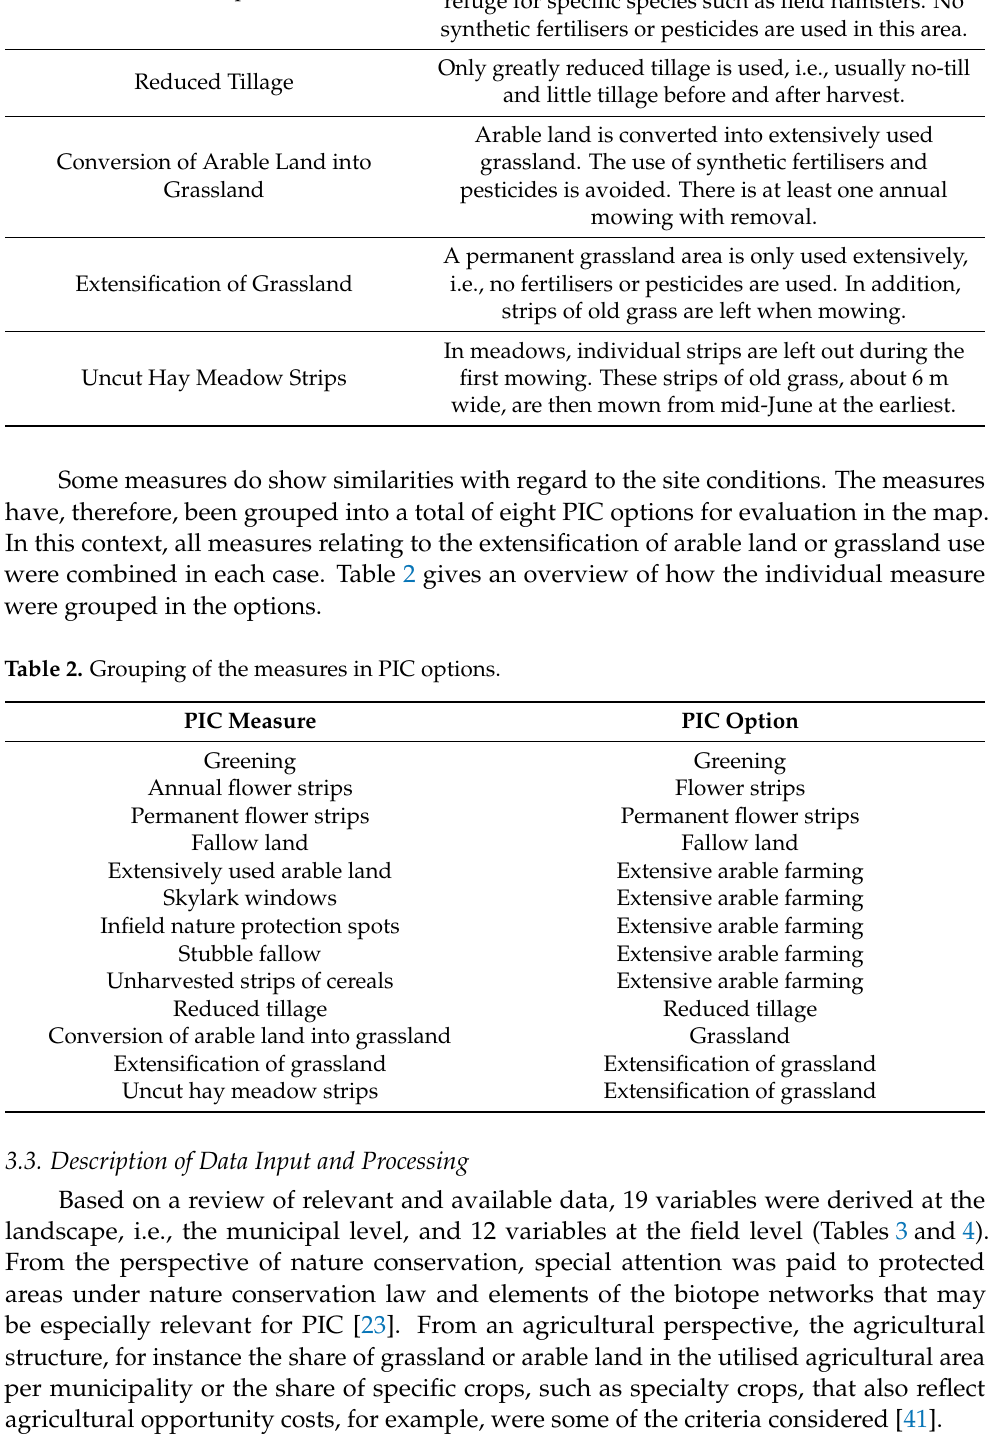
Unharvested Strips of Cereals